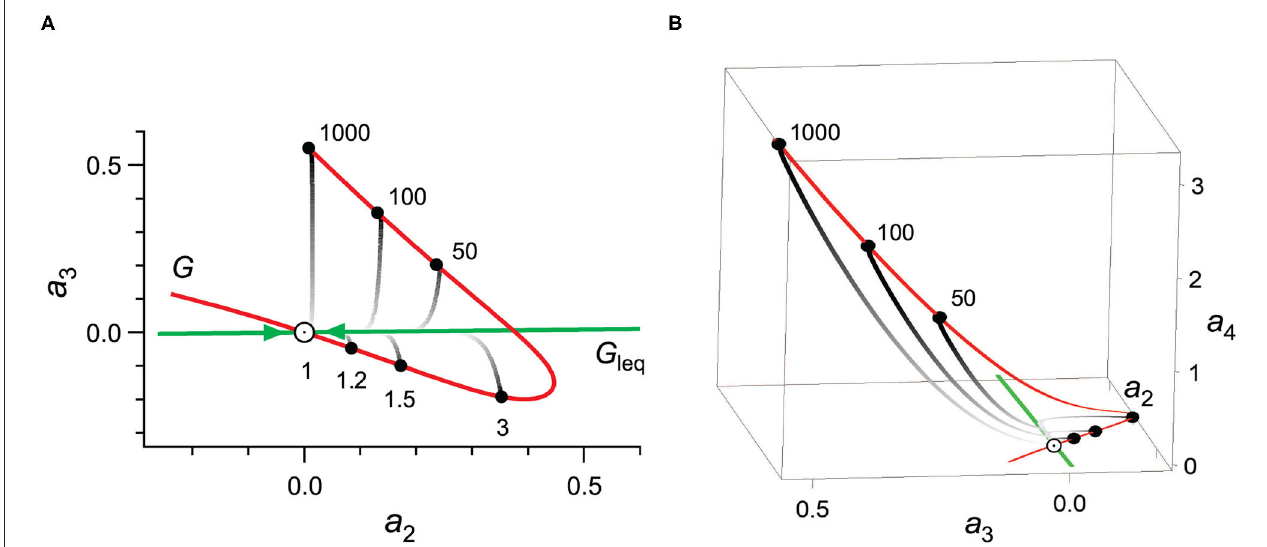
FIGURE 2 | Probability-density dynamics. (A) Two-dimensional dynamics in the plane defined by the a 2 and a 3 coefficients. (B) Three-dimensional dynamics defined by projections onto the a 2 , a 3 , and a 4 coefficients. In both cases, the red curve G denotes the set of equilibrium densities; the green curve represents G leq the set of local-equilibrium densities. Arrows indicate the slow relaxation along G leq to global equilibrium, at the intersection with G (denoted by the large hollow marker with a dot at its center at T = 1). Gray lines denote the rapid relaxation from an initial condition (temperature relative to the bath indicated by a marker along G ). The time progression of p ( x , t ), projected onto the a 2 – a 3 plane, is from dark to light. Curves are calculated from the double-well potential described in Kumar and Bechhoefer, with domain asymmetry α = 3 (see [ 25] for